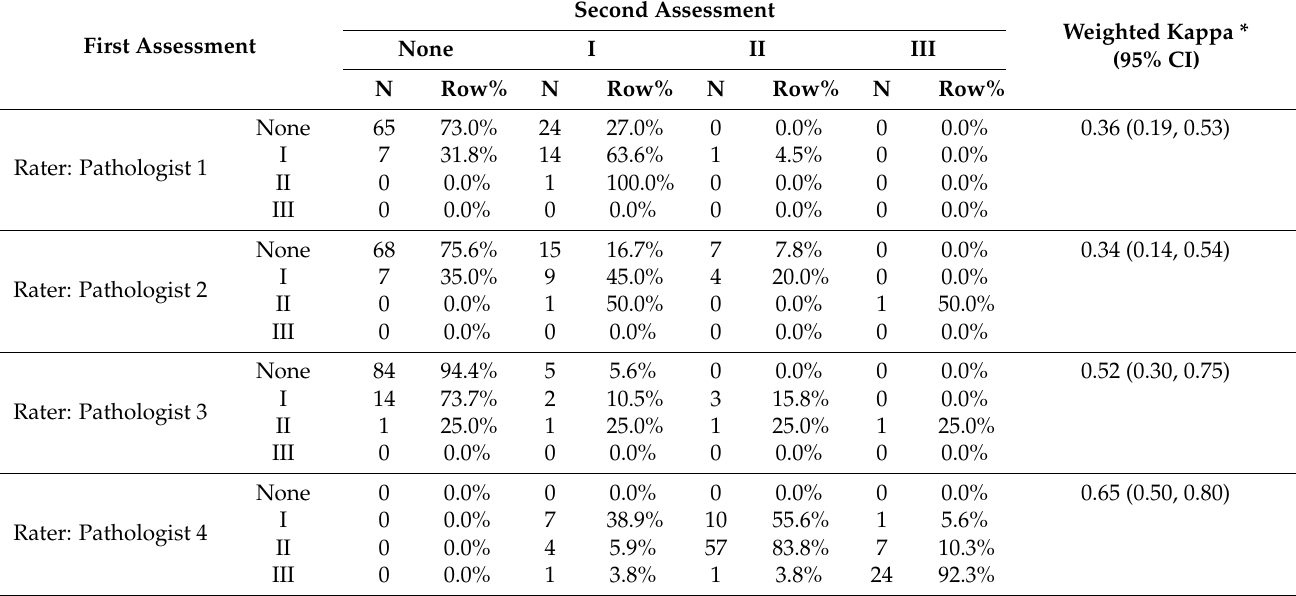
Figure 1. Pictures of an OLL, with magnification on different zones of the same lesion. ( a ) Overview, ( b ) detail of an area with no atypia, ( c ) detail of an area with the presence of atypical keratinocytes. The dysplasia grading among the four experts for the whole slide was as follows (first evaluation/second evaluation at 3 months. Expert 1: dysplasia grading 0/2; Expert 2: dysplasia grading 1/2; Expert 3: dysplasia grading 2/2; Expert 4: dysplasia grading 2/3. Dysplasia grading: 0 = none, 1 = mild, 2 = moderate, 3 = severe. Table 1. Intra-rater reliability of the dysplasia assessment for each rater, and